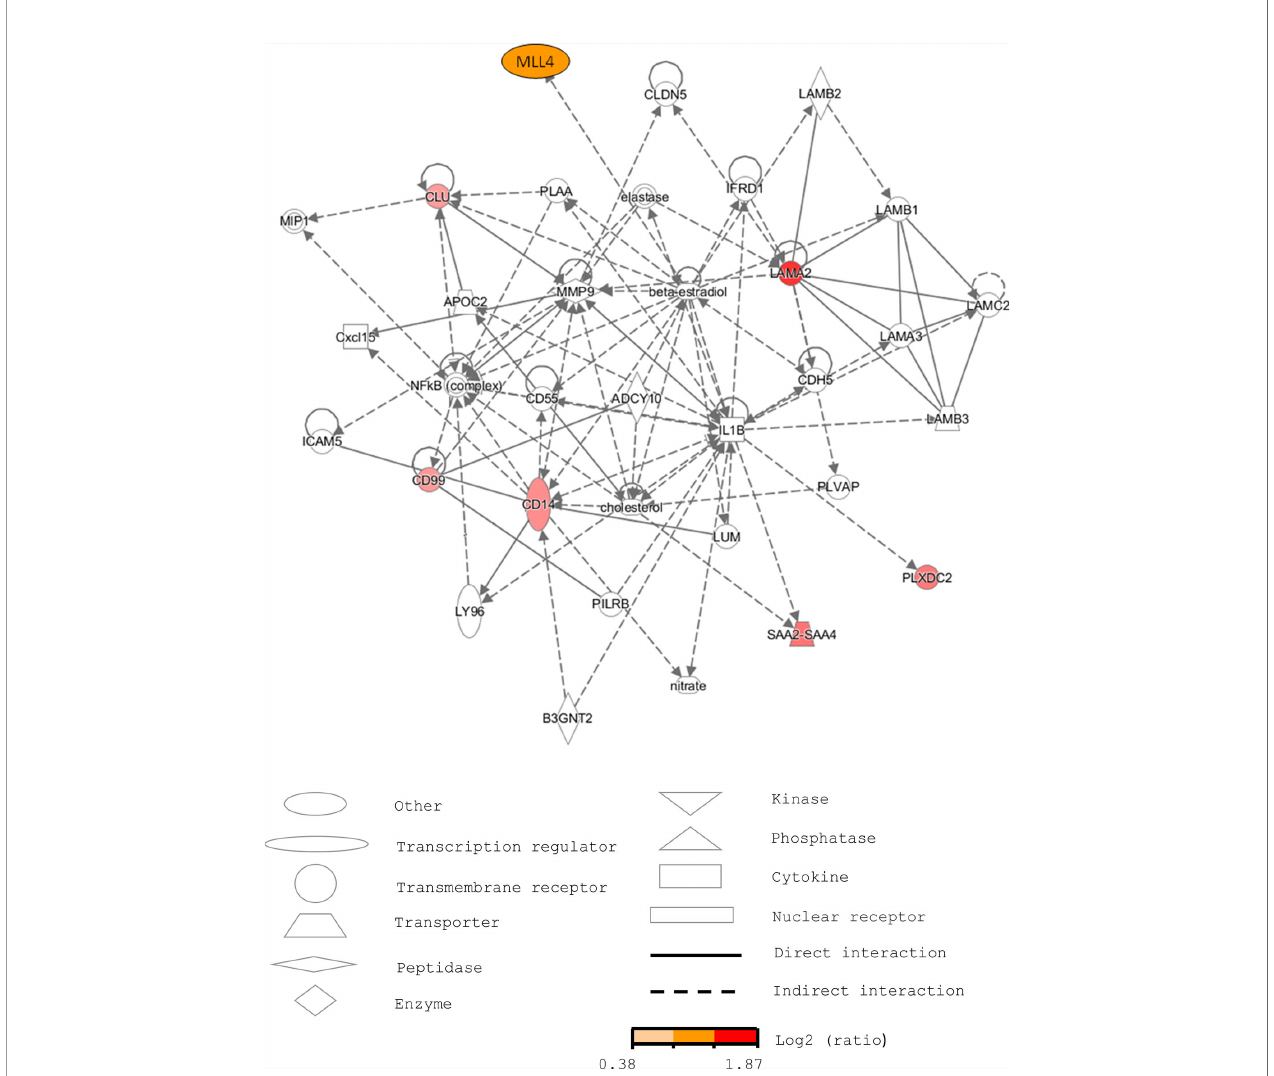
FIGURE 3 | Pathway analysis of the selected serum proteins from human sera using IPA. The network is related to connective tissue disorders, dermatological diseases and conditions, and developmental disorders. The markers increased in pre-diabetic patients are labeled in